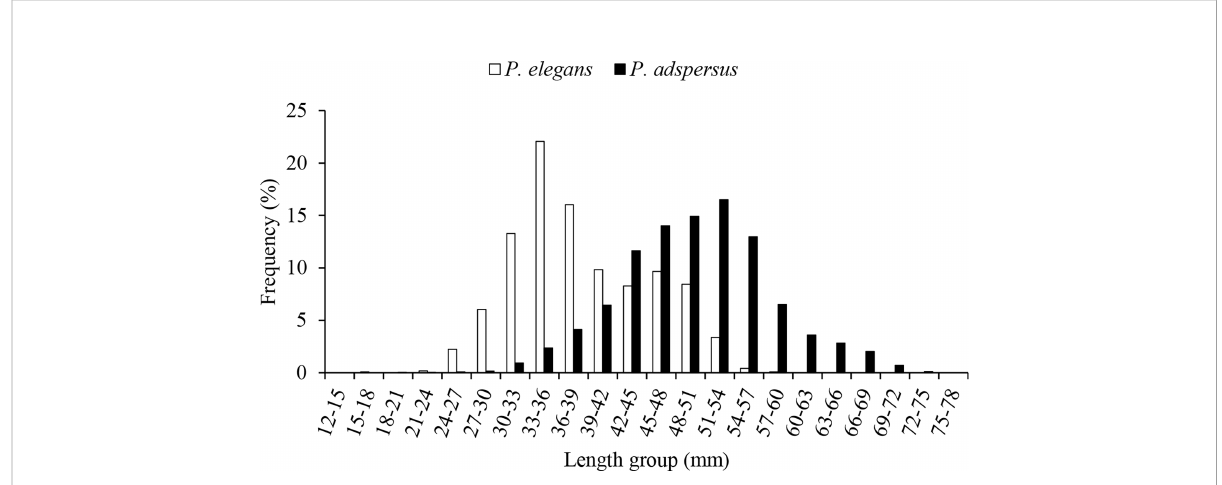
FIGURE 3 Length-frequency distributions of the shrimps P. adspersus and P. elegans from the southeast Caspian Sea (2019-2020).